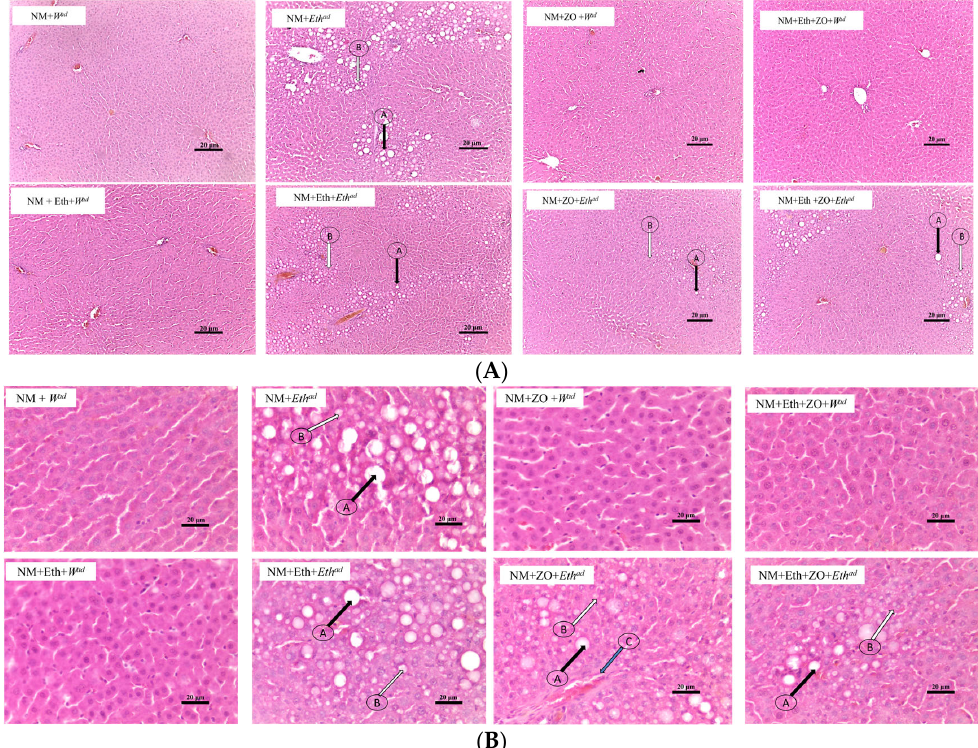
Figure 4. Photomicrographs of male ( A ) liver sections stained with H&E. Magnification ×10 arrows Photomicrographs of male ( B ) liver sections stained with H&E. Magnification ×40 arrows A = large droplet macrosteatosis; arrows B = small droplet macrosteatosis; arrows C = inflammatory cell infiltrate; arrow D = microsteatosis. NM—nutritive milk; Eth—ethanol; ZO—zingerone; W—water; ad —adult treatment.